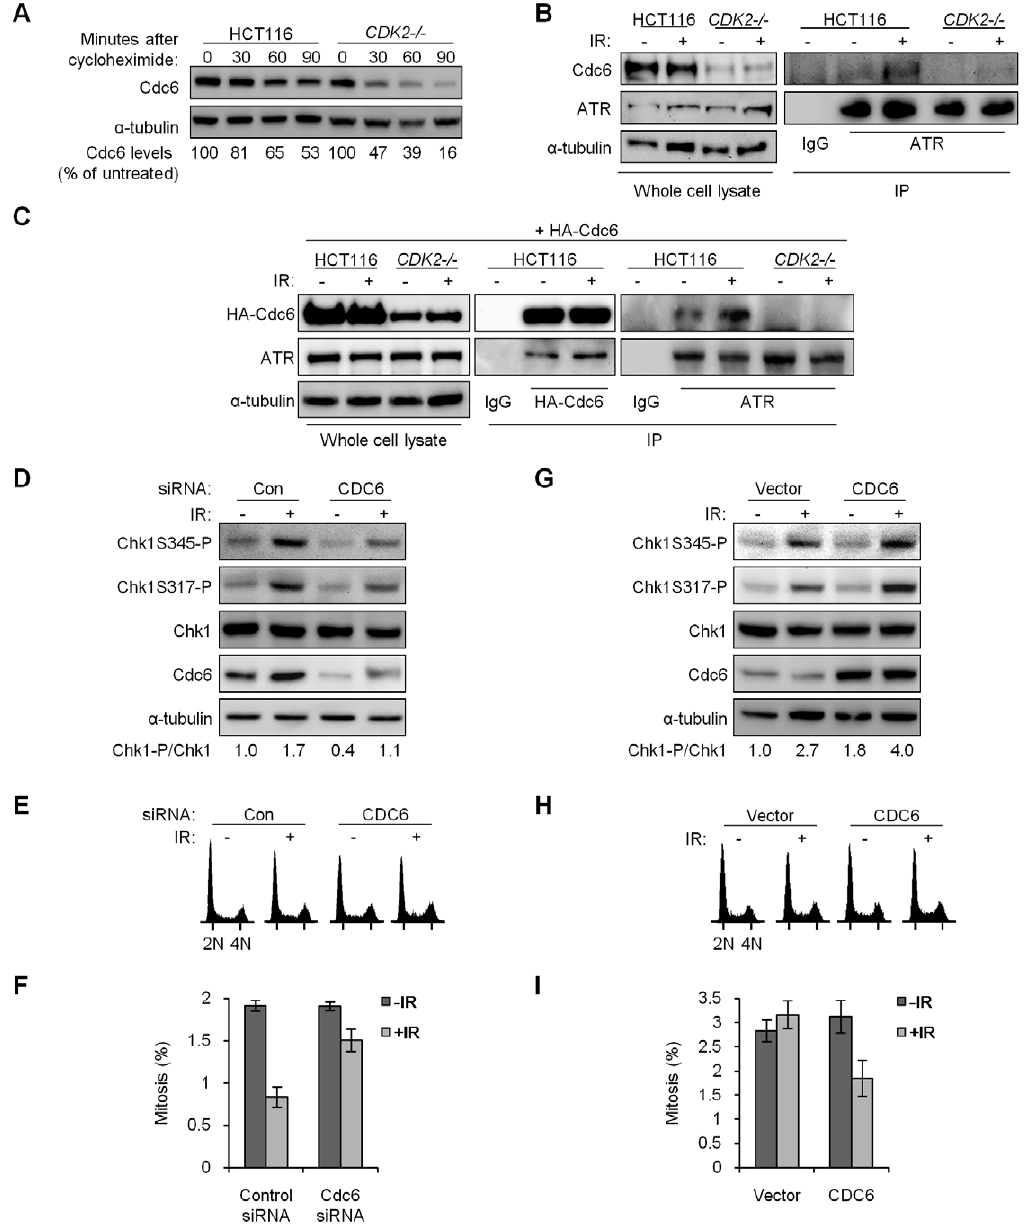
Figure 6. Stabilized Cdc6 facilitates Chk1 phosphorylation, associates with ATR, and controls mitotic entry. (A) Cdc6 protein stability was analyzed by immunoblot in wild-type and CDK2 2 / 2 cells at the indicated times after cycloheximide treatment. Cdc6 levels were quantitated, normalized to a -tubulin, and represented as a percentage relative to untreated control cells. (B) Physical interaction between endogenous Cdc6 and ATR. Non-denatured cell lysates from the indicated cell lines were collected before or 4 h after 12 Gy IR. Lysates were subjected to immunoprecipitation (IP) with anti–ATR or isotypic control (IgG) antibodies. Samples not subjected to immunoprecipitation were analyzed as whole cell lysate. Levels of ATR and Cdc6 were determined by immunoblot. (C) Isogenic HCT116 cells were transfected with a plasmid expressing HA-tagged Cdc6 (HA-Cdc6). Transfected cells were untreated or treated with 12 Gy IR and lysed after 4 h. Non-denatured cell lysates were subjected to immunoprecipitation (IP) with anti–HA, anti–ATR, or isotypic control (IgG) antibodies. Samples not subjected to immunoprecipitation were analyzed as whole cell lysate. Levels of ATR and HA-Cdc6 were determined by immunoblot. (D–F) U2OS cells were transfected with control (Con) or CDC6 (CDC6) siRNA. (D) Lysates were taken before and 4 h after treatment with 12 Gy IR. Chk1 and Cdc6 levels were analyzed by immunoblot. Relative Chk1-phosphorylation (Chk1-P/Chk1) was determined by quantitation of Chk1S317-P plus Chk1S345-P followed by normalization to total Chk1. (E) Cells were fixed and stained with Hoechst 33258 and subjected to flow cytometry before and 4 h after treatment with 12 Gy IR. (F) Cells fixed and stained for histone H3S10-P before and 24 h after treatment with 4 Gy IR and 1 m g/ml nocodazole, mitotic index was determined by indirect immunofluorescence. Error bars represent s.e.m. from three independent experiments. (G–I) CDK2 2 / 2 P53 2 / 2 cells were transfected with an empty vector or Cdc6 expression vector. (G) Lysates were taken before and 4 h after treatment with 12 Gy IR. Chk1 and Cdc6 levels were analyzed by immunoblot. (H) Cells were fixed and stained with Hoechst 33258 and subjected to flow cytometry before and 4 h after treatment with 12 Gy IR. (I) Cells fixed and stained with Hoechst 33258 before and 24 h after treatment with 12 Gy IR and 0.2 m g/ml nocodazole, mitotic index was determined by fluorescence microscopy. Error bars represent s.e.m. from six independent experiments.